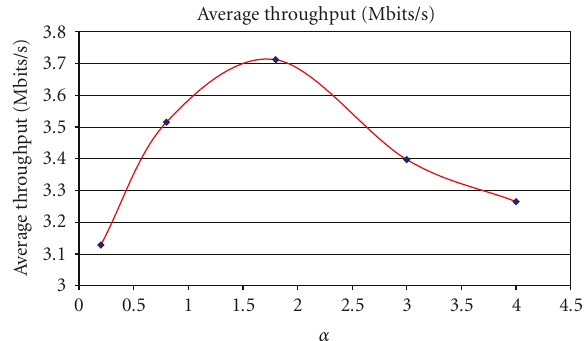
Figure 6: Performances of BMAC when using di ff erent coherence